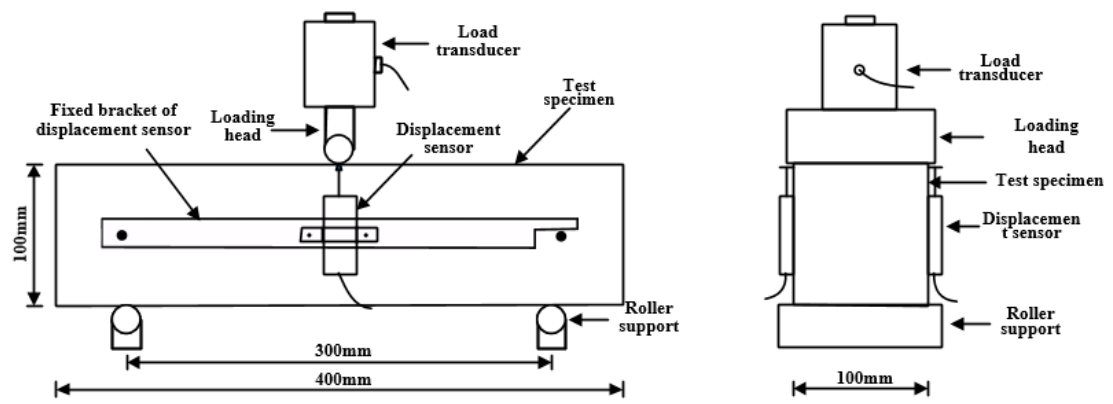
Figure 11. Schematic diagram of the three-point bending test.